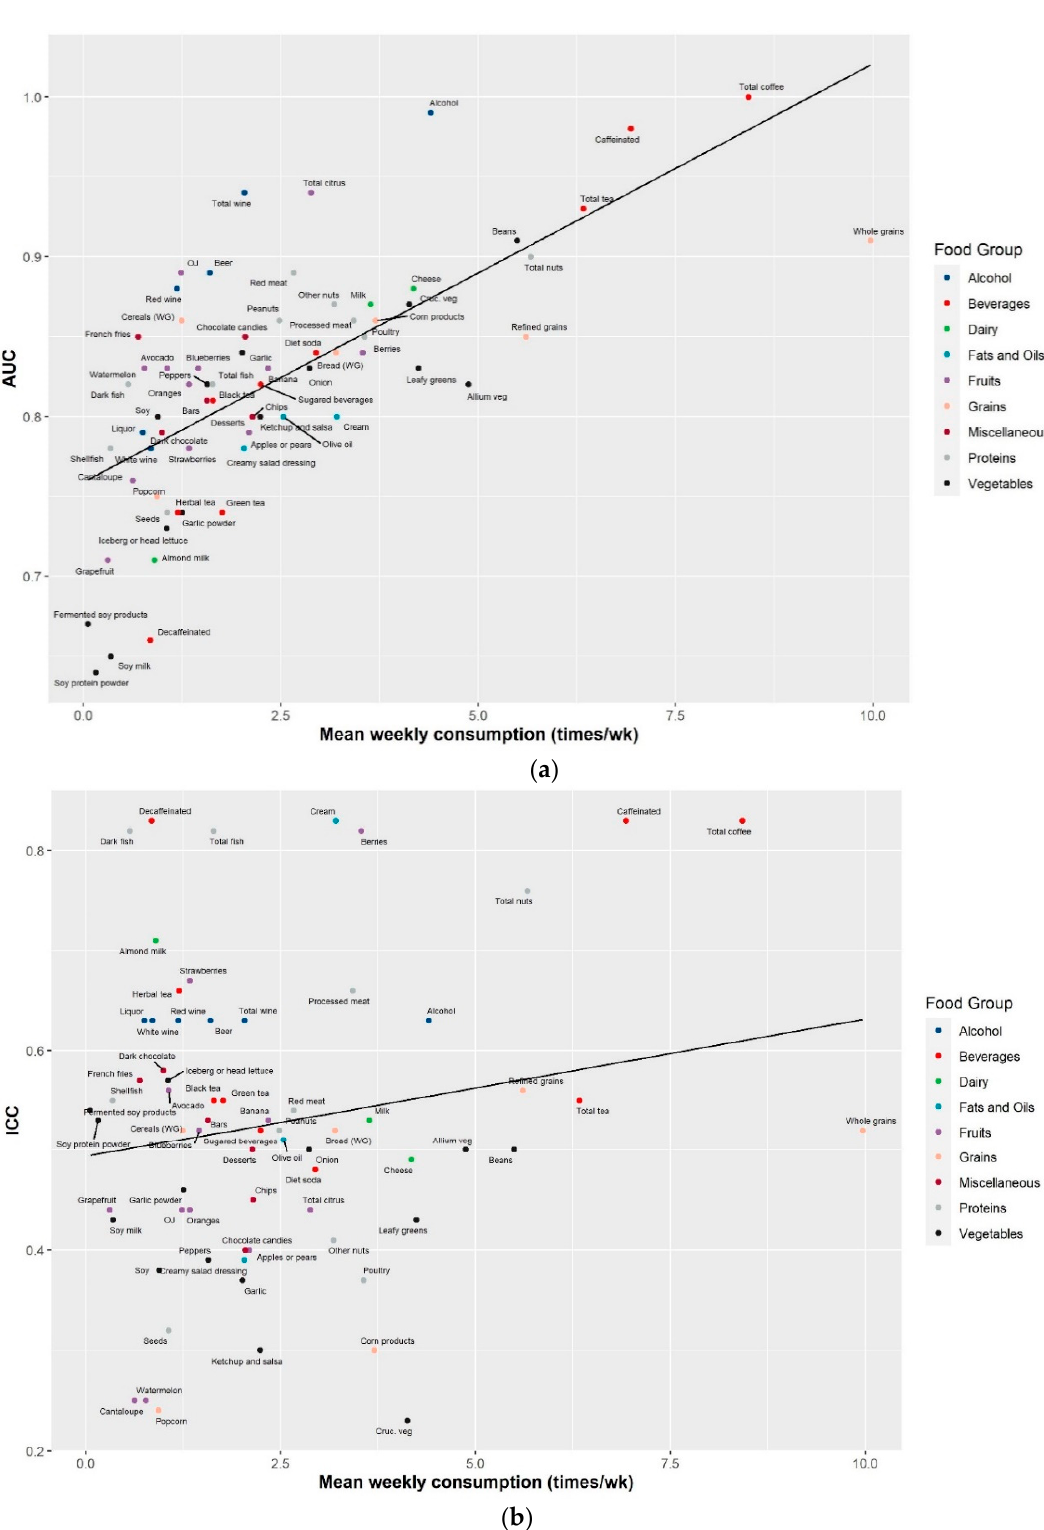
of 79 food groups/items in the Cancer Prevention Study-3 Diet Assessment Sub-study. ( a ) The most predictive metabolites for 71 food groups/items assessed using the food frequency questionnaire; ( b ) the most predictive metabolites for 60 food groups/items assessed using the average of 24 h diet recalls. Prediction accuracy was assessed by area under the curve (AUC) from the receiver operating characteristic curve, which indicates how well a metabolite could discriminate top quartile from bottom quartile intake of a food group/item. Reproducibility was assessed by intraclass correlation coeffi- cients (ICCs), calculated as the ratio of between-person variance to the total variance among participants with repeated blood metabolic profiles measured six months apart.